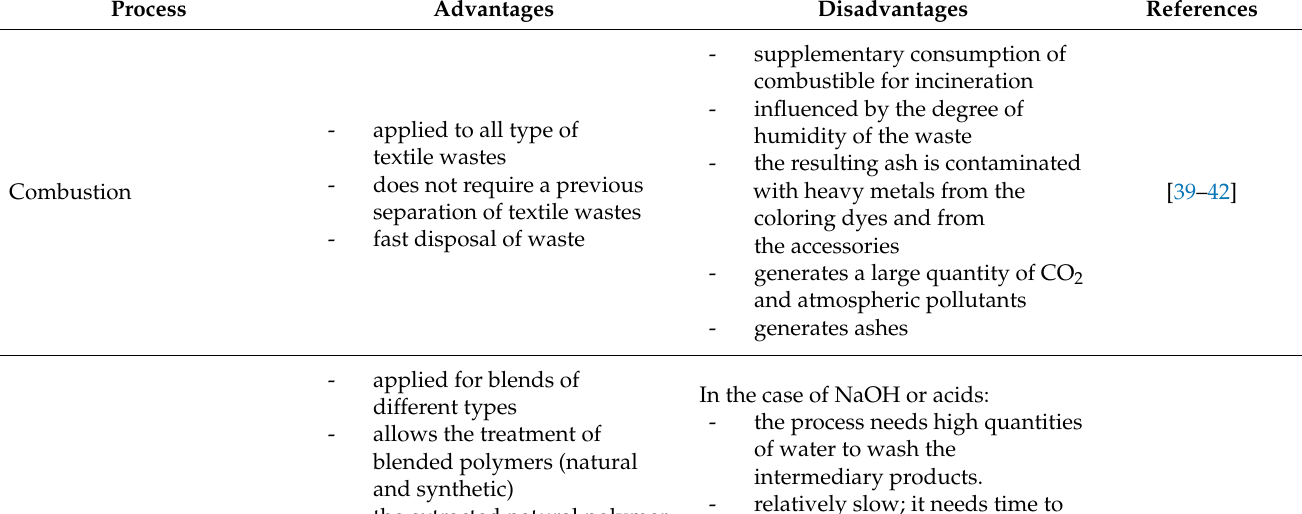
Table 1. Main methods for the treatment of textile